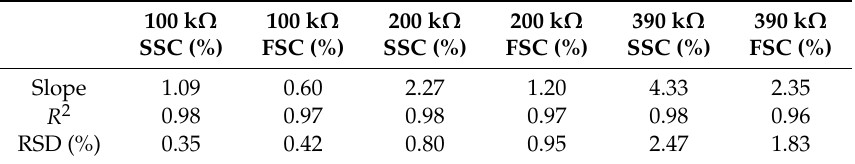
Table 2. Summary of the measured SSCs and FSCs of R6G labeled HeLa cells using load resistors at different concentrations with no excitation filter and #389 emission filter (500 nm), n = 12/cell numbers.